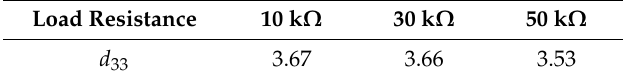
Table 1. Values of the d 33 coefficients (pC/N) for electrospun spider silk nanofibers.